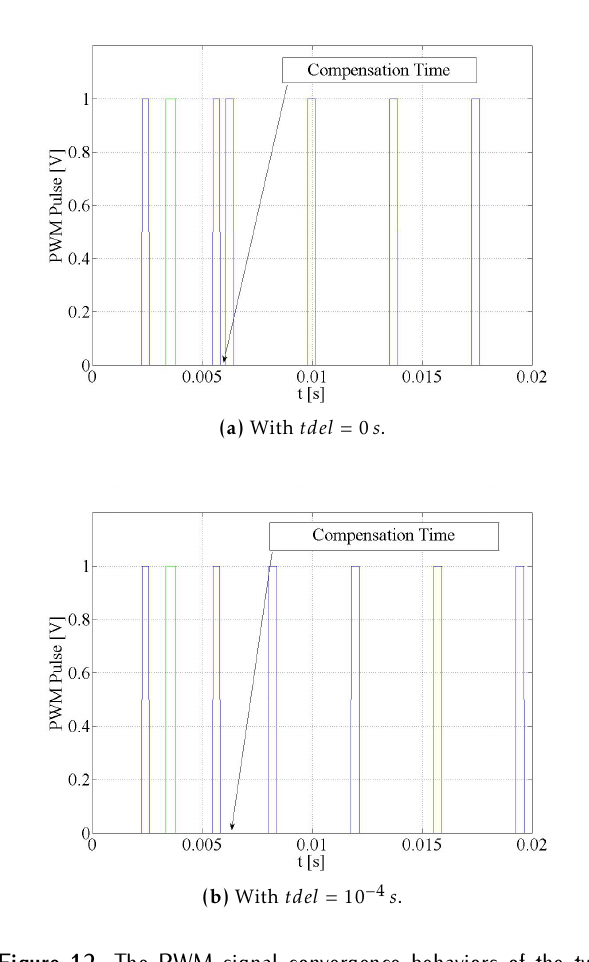
Figure 12. The PWM signal convergence behaviors of the two